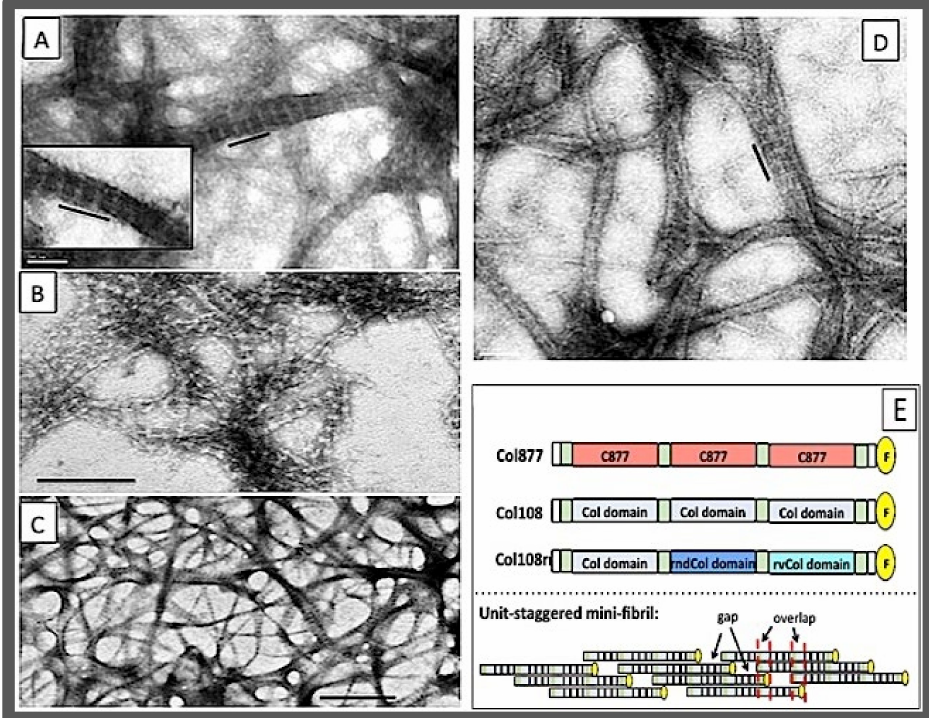
Figure 6. The unit-staggered mini-fibrils with a 35-nm d -period. ( A – D ) TEM images of Col108 mini- fibrils (13). The scale bars are 100 nm in ( A , D ), 200 nm in ( B ), and 500 nm in ( C ). ( E ) The schematic depictions of the peptides and the unit-staggering of the mini-fibril. The identical sequence units (SUs) are shown as rectangles in the same color: Col877 (3 red), Col108 (3 light blue), Col108rr (3 different SUs in three different colors); the yellow circles represent the foldon domain; the (GPP) 4 sequence that is present in the N-terminus of each SU is shown in green blocks (13). The unit-staggered mini-fibrils are drawn to highlight the alternating gaps and overlap zones, and the in-register alignment of the interacting residues (black vertical